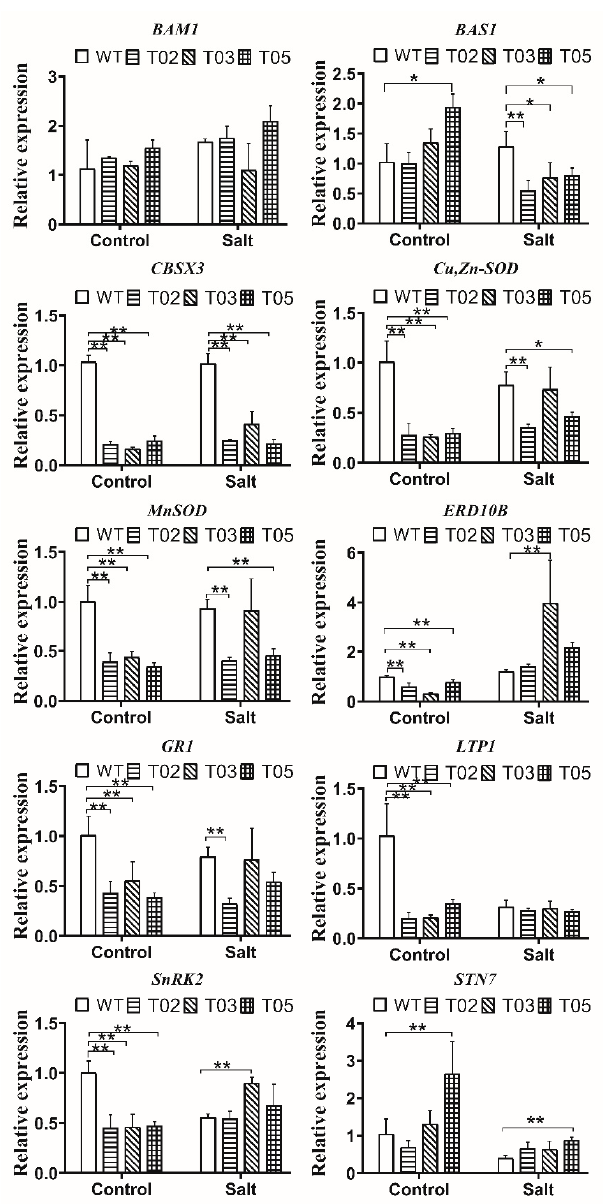
Figure 4. Expression pattern of stress-response genes in overexpressed MsTRX tobacco under salt stress. BAM1 : beta-amylase 1. BAS1 : phyB activation-tagged suppressor 1. CBSX3 : candidate signal molecules/sensor relay proteins. Cu/Zn-SOD : superoxide dismutase [Cu-Zn]. Mn-SOD : superoxide dismutase [Mn]. ERD10B : dehydrin DHN1-like. GR1 : protein gamma response 1. LTP1 : lipid-transfer protein 1. SnRK2 : serine/threonine-protein kinase. STN7 : serine/threonine-protein kinase that phosphorylates LHCII protein 7. WT: wild type. T02: line 2. T03: line 3. T05: line 5. The error bars represent the means ± SDs of three independent biological replicates. *, p < 0.05. **, p <